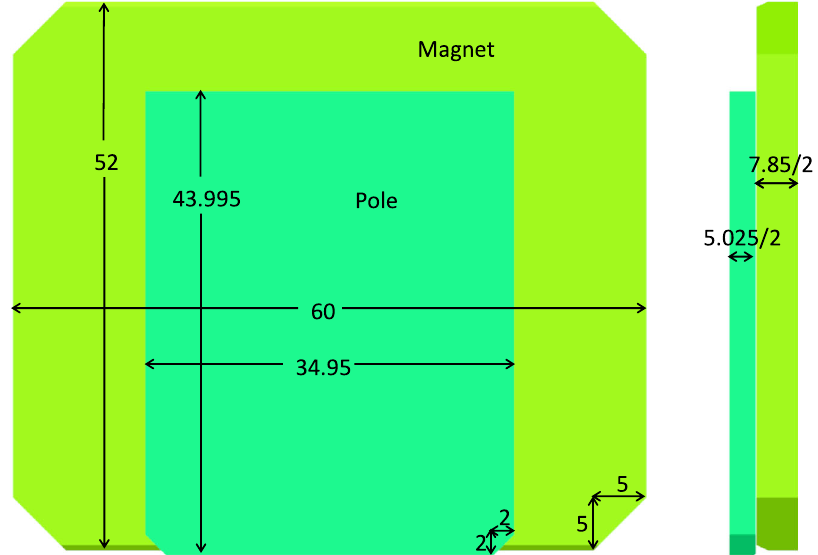
FIG. 4. Sketch of a quarter period of the magnetic design; only half of the thicknesses of the magnet and pole are shown. Dimensions are mm. Z chamfer dimensions and the magnet recess are given in Table